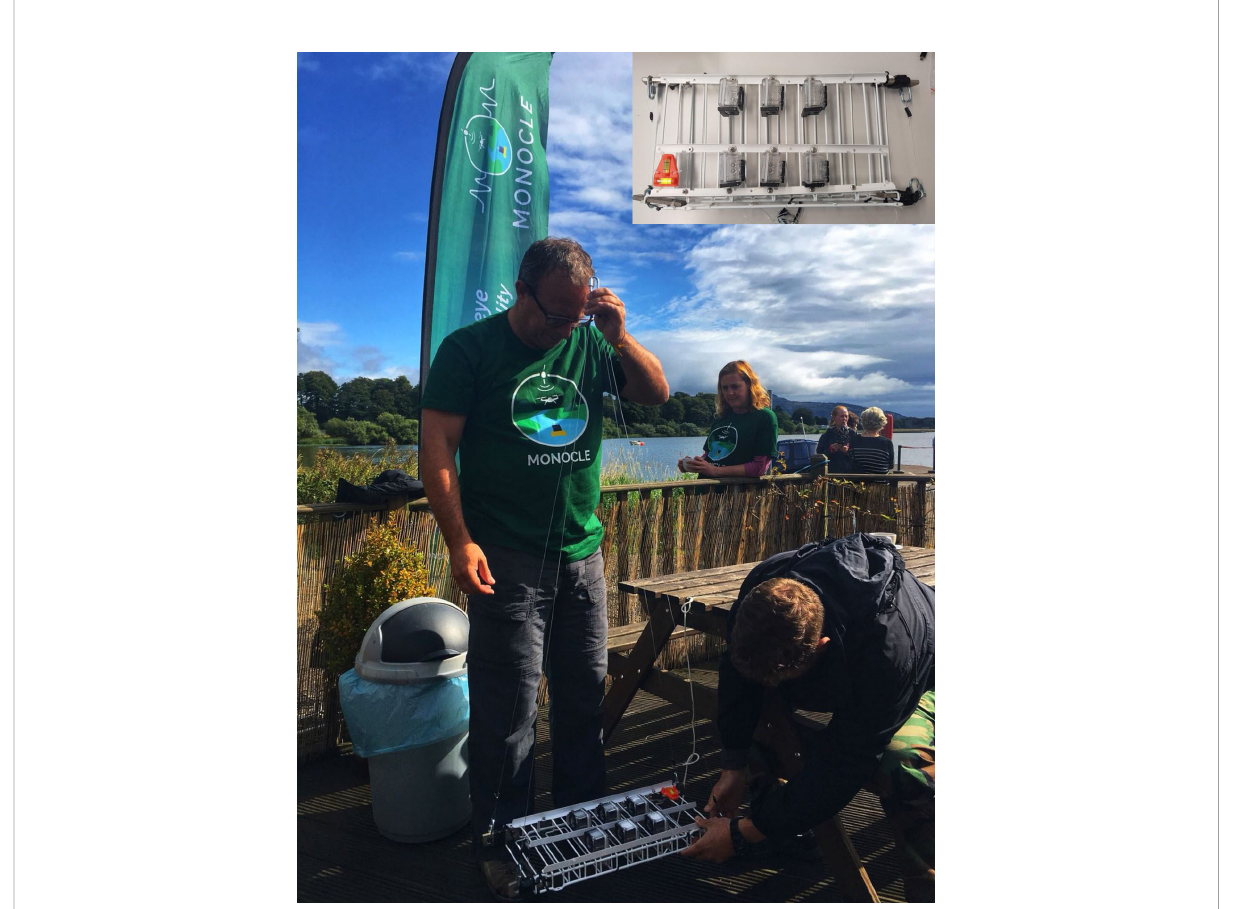
FIGURE 3 Concurrent measurements to derive theoretical K d uncertainty. The in situ measurements took place in the Stirling ’ s University campus (Airthrey Loch) and in the Loch Leven, in August of 2018. Six KduPRO (numbered as 13, 14, 15, 17, 18 and 19) were placed in the same plane at 1 m depth, doing measurements for 15 minutes at noon.